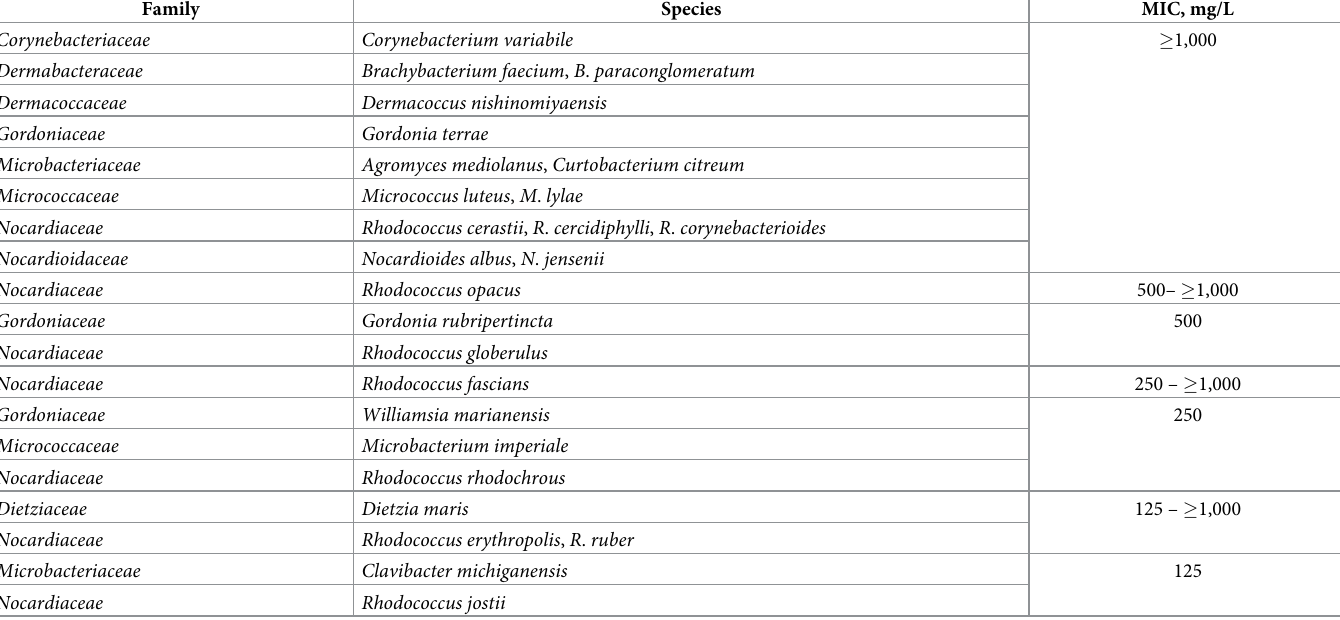
Table 1. Minimal inhibitory concentration (MIC) of IBP obtained for the tested actinobacterial strains.